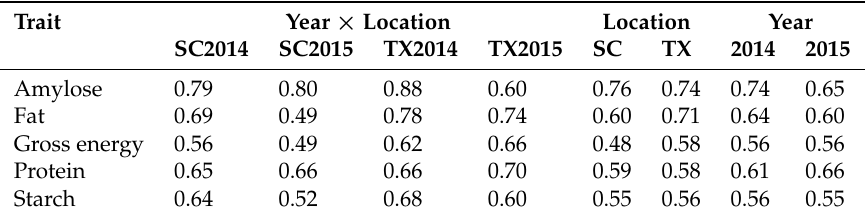
Figure 4. Prediction accuracy of whole environment predicted using the Bayesian multi-output regressor stacking (BMORS_Env) in the diversity panel (GSDP). The y-axis shows prediction accuracy calculated as Pearson’s correlation between observed values and predicted values of phenotypes. Values on top of the bar represent the height of the bar. Table 4. Prediction accuracy of the test environments predicted using the Bayesian multi-output regressor stacking (BMORS_Env) in the recombinant inbred lines (RILs). SC: South Carolina, TX, Texas. Prediction accuracy was calculated as Pearson’s correlation between observed values and predicted values of